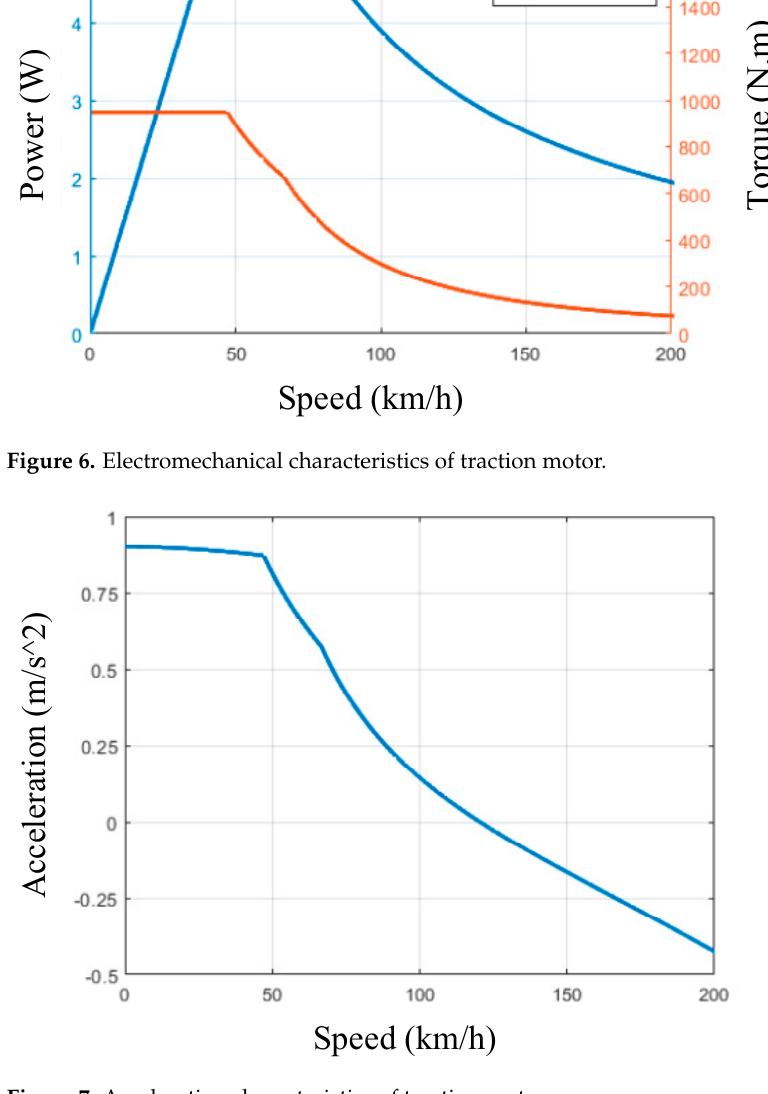
Figure 7. Acceleration characteristics of traction motor. Table 3. Parameters of line and traction power